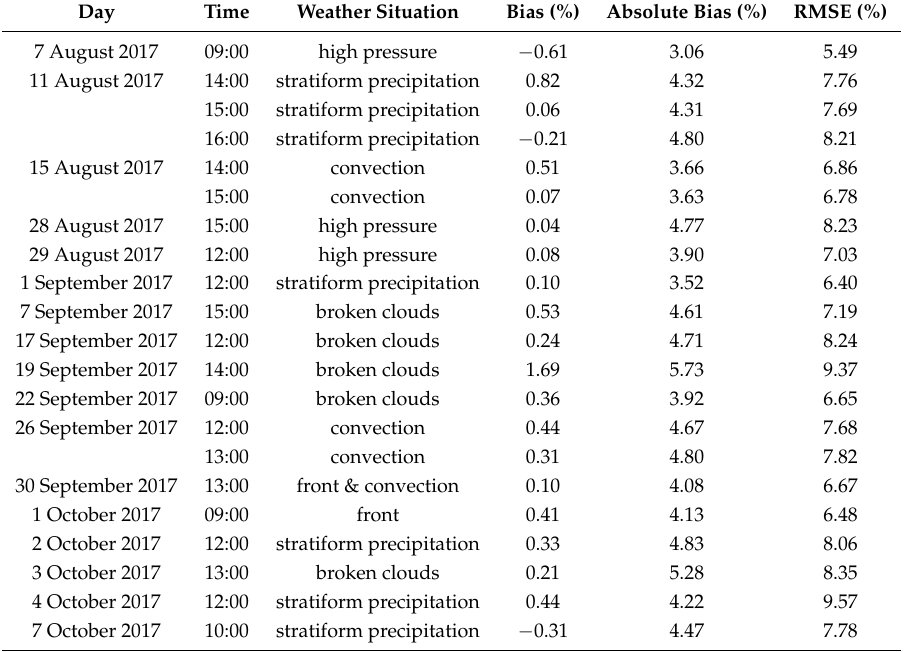
Table A1. List of investigated cases for the settings of the parameters in the TV- L 1 method for the optical flow estimation of the effective cloud albedo. The error measures were calculated for a 15-min-forecast over the area of